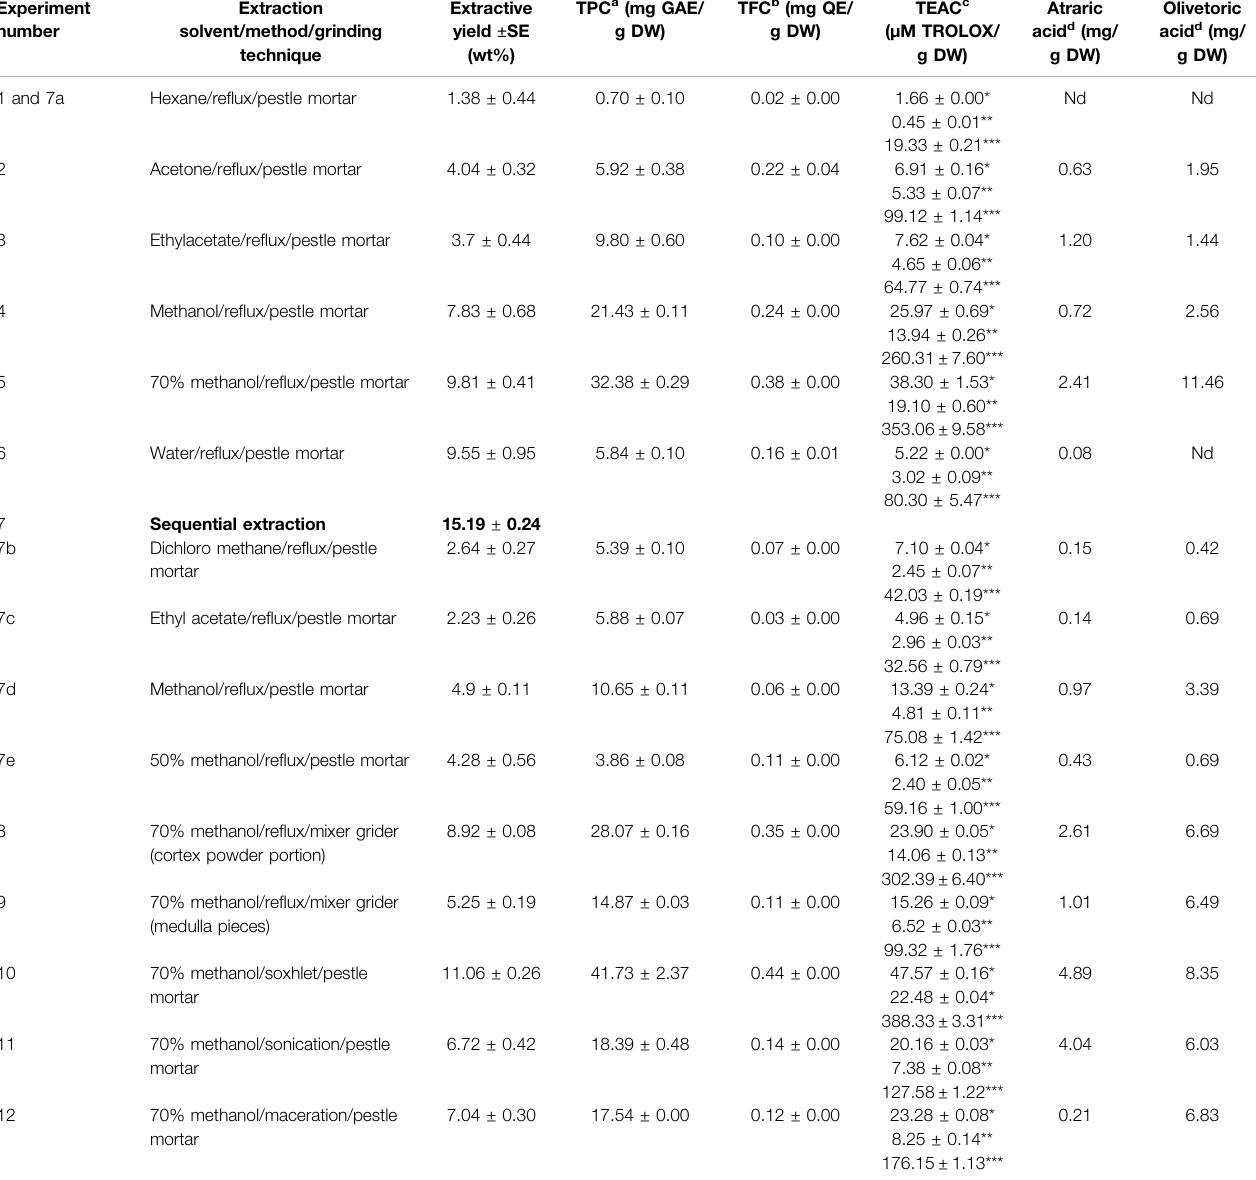
TABLE 1 | Extraction yield, total phenolics and antioxidant potential of P. furfuracea using different extraction solvents, grinding method and extraction method. Experiment